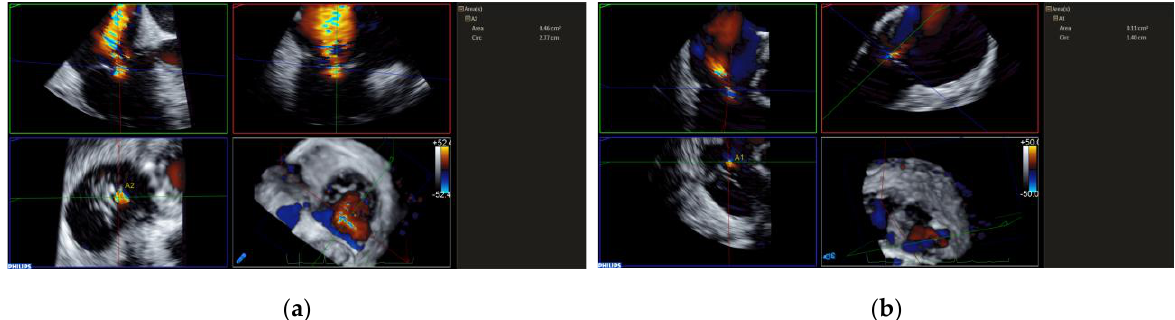
Figure 10. Measuring TR VCA before and after K-Clip ™ implantation. ( a ): VCA showing severe TR; ( b ): VCA showing residual mild-moderate TR after transcatheter tricuspid annuloplasty.